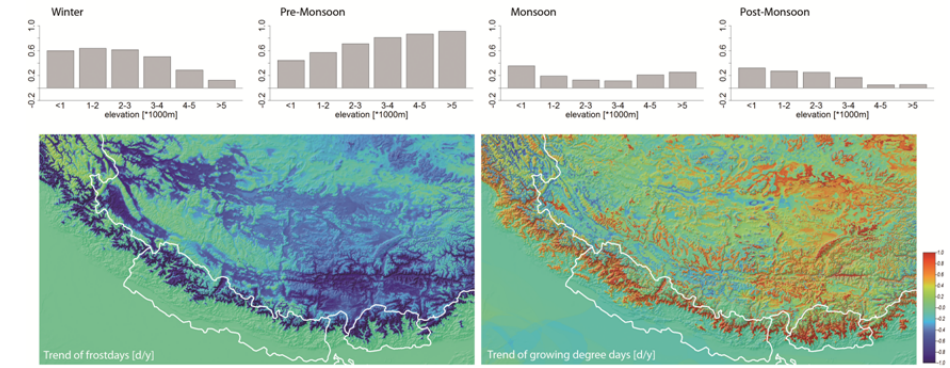
Figure 4. Seasonal temperature trends ( ◦ C per decade) for different elevational belts (top panels) and spatial distribution of trends for frost and growing degree days over the Himalaya (bottom panels) (according to Gerlitz et al., 2014).